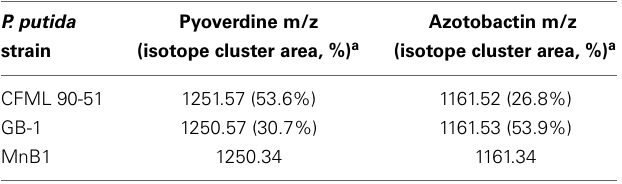
each PVD in partially purified preparations from the P. putida Table 3 | Mass spectrometric (MS/MS) analysis of siderophores from several siderotype n ◦ 1 strains of Pseudomonas